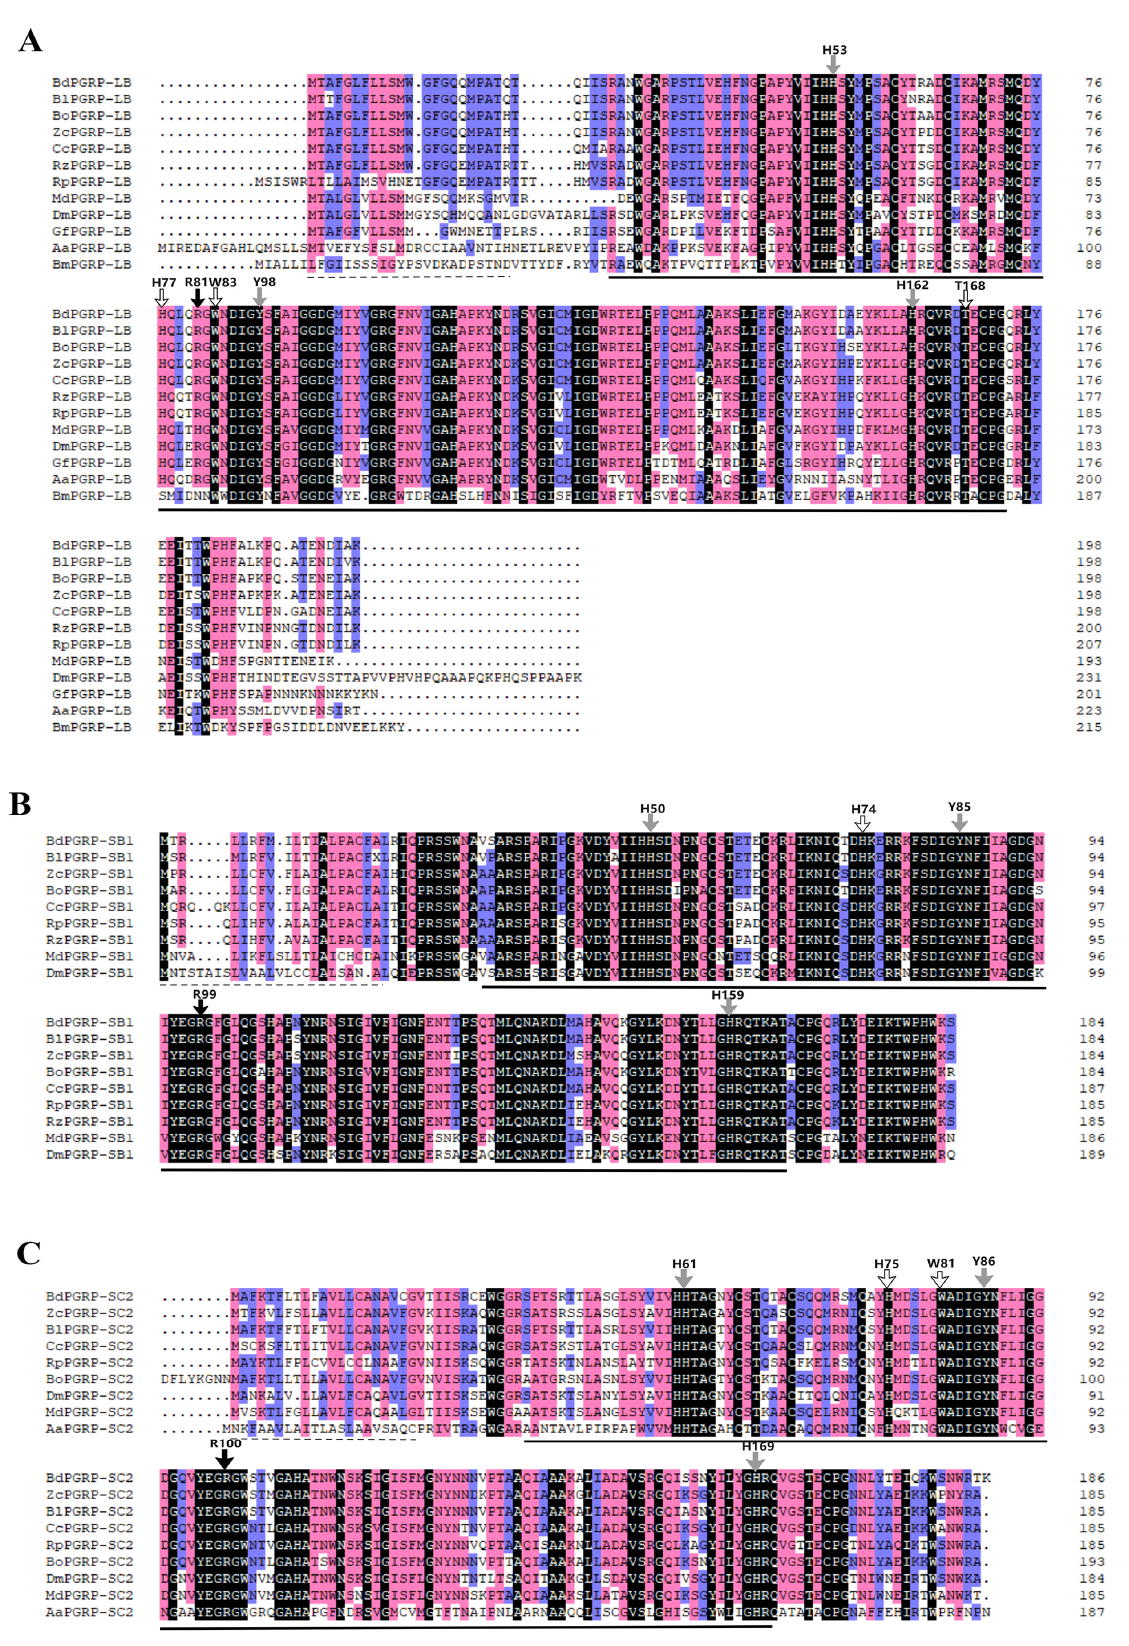
Figure 1. Amino acid sequence alignment of BdPGRPs with that of homologous genes in